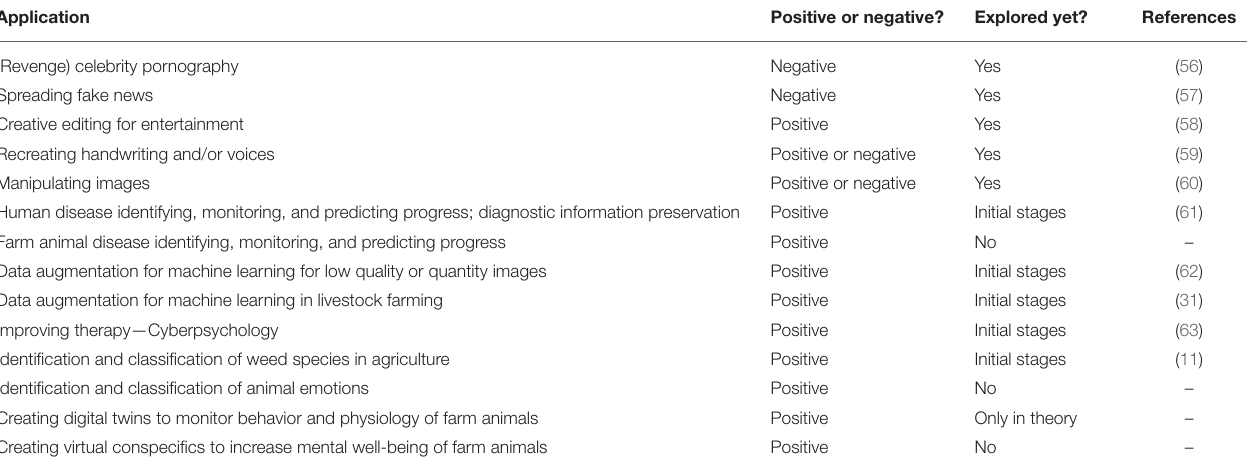
TABLE 1 | Summary of current and potential applications of GANs and deepfake technologies.